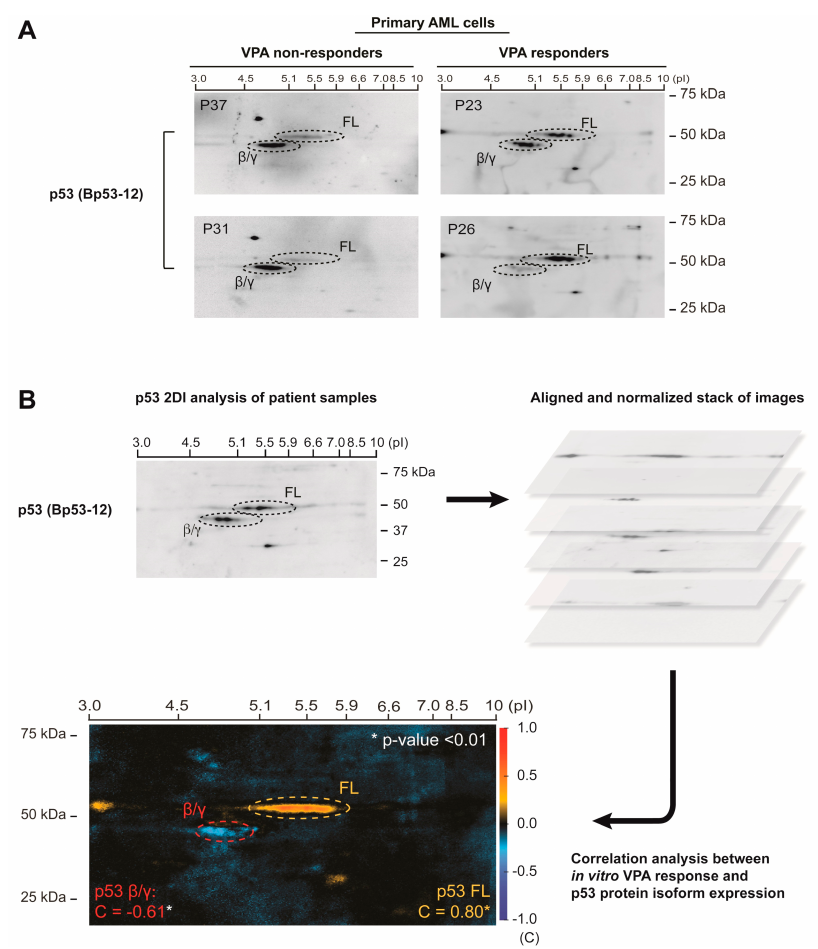
Figure 1. Correlation analysis between p53 protein isoform expression and in vitro sensitivity to valproic acid in primary AML cells. AML samples from 21 patients were analyzed by 2D gel electrophoresis with separation of proteins according to molecular weight (kDa) and isoelectrical point (pI), and Western blotting using an antibody against p53 (Bp53-12) for detection of p53FL, p53 β and p53 γ protein isoforms. In vitro VPA sensitivity was determined by treatment of cells with VPA (0 and 0.5 mM) for 48 h followed by an assessment of proliferation by 3 H-thymidine incorporation assay. Proliferation values were calculated as % VPA response (decrease in proliferation) compared to untreated control. Examples of p53 protein isoform expression in p53 2D gel images from patient samples with low and high sensitivity to VPA are shown in ( A ). Correlation analysis between p53 protein isoform expression and VPA sensitivity was performed. Regions with significant correlation values are indicated (the red color indicates positive correlation, the blue color indicates negative correlation): β / γ region: correlation coefficient = − 0.61, t -value = 5.50, p -value < 0.005, FL: correlation coefficient = 0.80, t -value = 5.96, p -value < 0.005 ( B ).